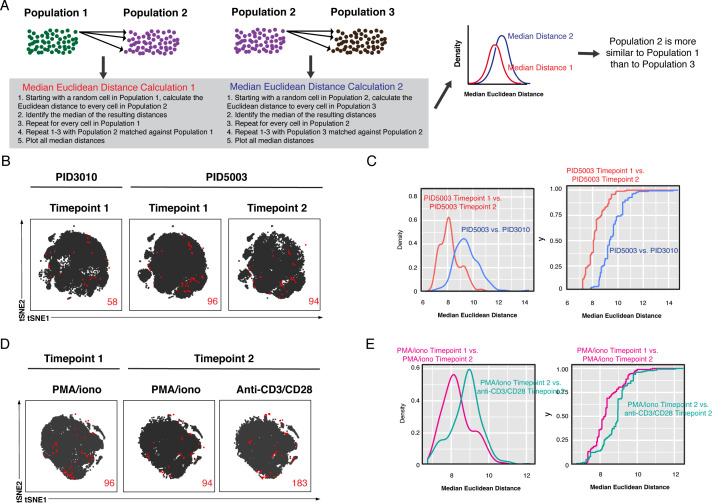
Characterization of the inter-donor and stimulation-dependent variability in kNN latent cells.(A) Schematic of Euclidean distance calculations to assess relative similarities between different populations of cells. In this hypothetical scenario, one seeks to determine whether Population 2 is more similar to Population 1 or to Population 3. To do this, the median Euclidean distances, based on all the CyTOF parameters, are calculated for each pair of populations as shown. The resulting data are depicted as density plots. The pairs of samples with lower distance calculations are more similar. In this hypothetical scenario, Population 2 is most similar to Population 1. (B) The atlas and kNN latent cells from three leukapheresis specimens from two donors are represented as tSNE plots. The two specimens from donor PID5003 were obtained 2 months apart. Red numbers indicate the number of kNN latent cells in each plot. (C) The kNN latent cells of the two PID5003 specimens are more similar than the PID5003 specimens are to the PID3010 specimen. The empirical cumulative distribution of median distances was calculated between (1) kNN latent cells from the two PID5003 specimens (red), and (2) kNN latent cells between the PID3010 specimen and the PID5003 Time point 2 specimen (blue). The plot on the left shows the distribution of the data plotted as density plots. The plot on the right shows the same data plotted as empirical cumulative distribution curves, where the y-axis value corresponds to the proportion of the median distances that are less than the corresponding x-axis value. In both plots, the more similar two specimens are, the more the curves are shifted to the left. (D) The kNN latent cells from three leukapheresis specimens from the same donor (PID5003), reactivatable with either PMA/ionomycin or anti-CD3/CD28 as indicated. Red numbers indicate the number of kNN latent cells in each plot. (E) The kNN latent cells reactivatable by PMA/ionomycin at the two different time points are more similar than those reactivatable by PMA/ionomycin versus anti-CD3/CD28 at the same time point. The empirical cumulative distribution of median distances was calculated between (1) kNN latent cells of the Time point 1 PMA/ionomycin and Time point 2 PMA/ionomycin samples (red) and (2) the Time point 2 PMA/ionomycin and Time point 2 anti-CD3/CD28 samples (blue). The density plots and empirical cumulative distribution curves are depicted on the left and right sides, respectively.